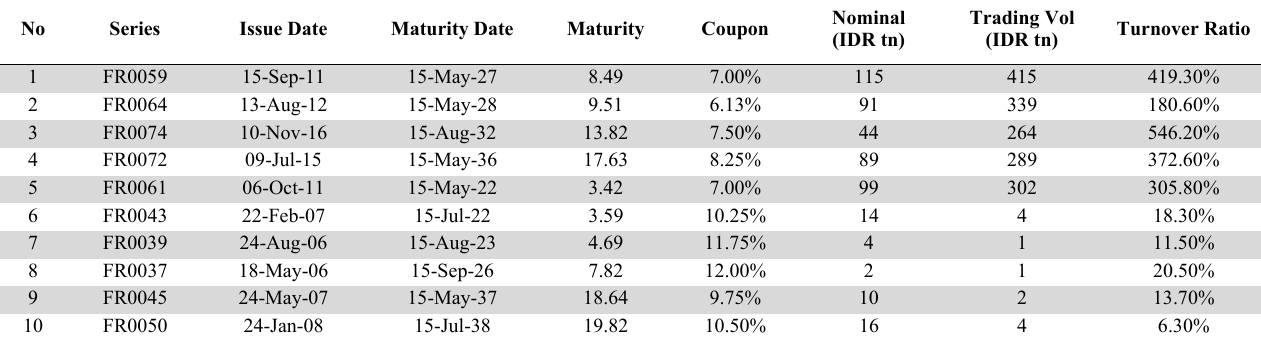
Information on bond series of Indonesia government